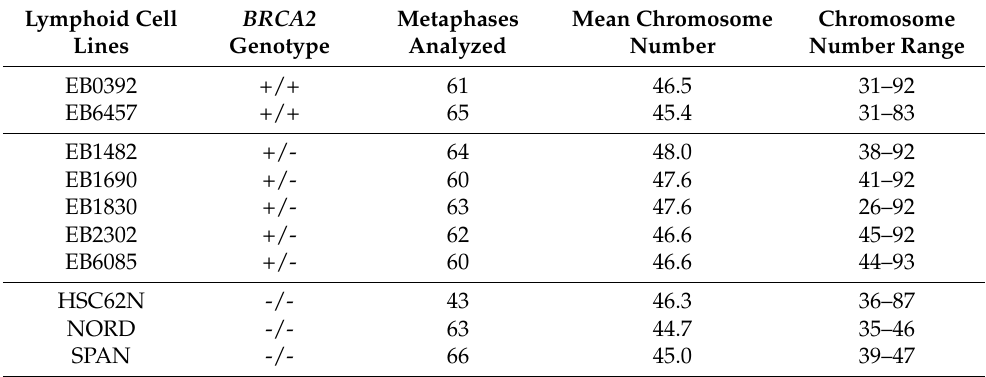
Table 2. Metaphase number analyzed in each lymphoid cell line including information about mean chromosome number and the chromosome number